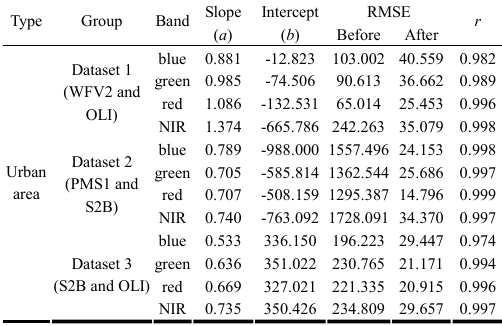
normalization. Table 5-7 list the normalization coefficients for each band for the three group experiments. All of